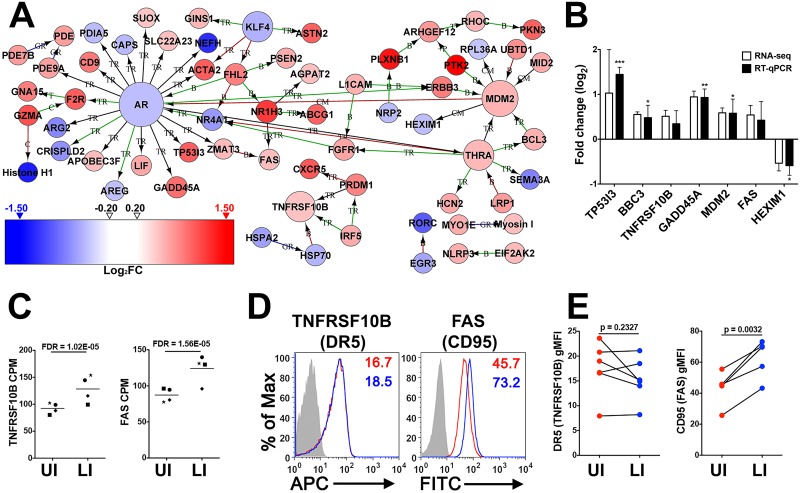
Functional analysis of genes modulated in HIV-1 latency.(A) Protein interaction network (PIN) generated using differentially expressed genes (N = 826) after a log2FC > 0.5 filter was applied (N = 64). Any single nodes not attached to a main hub were removed for clarity. Abbreviations for the type of interaction are as follows: B–Binding, C–Cleavage, CM–Covalent Modification, GR–Group Relation, +P–Phosphorylation, TR–Transcription Regulation, T–Transformation. Edge coloring of Green indicates activation, Red indicates inhibition, Black indicates unspecified, while Blue is utilized for a group relation. Arrows indicate the direction of interactions. The color gradient of log2FC for (A) is included with red indicating upregulation and blue indicating downregulation. (B) RT-qPCR validation of a panel of p53 related genes modulated in HIV-1 latency. Fold change is plotted on the log2 scale with error bars representing standard deviation. Significance for RT-qPCR results was determined with a paired t-test (*p<0.05, **p<0.01, ***p<0.001) and all RNA-Seq results were significant (EdgeR’s FDR corrected p-value < 0.05). (C) Dot plots of gene expression data (i.e., counts per million) from RNA-Seq results for TNFRSF10B (DR5) and FAS (CD95). Abbreviations: UI, uninfected; LI, latently infected. (D) Histograms of DR5 (TNFRSF10B) and CD95 (FAS) protein surface expression from a representative donor. Red line indicates UI and blue line indicates LI. Geometric mean fluorescence intensity (gMFI) is indicated at the right top corner of the histogram and the grey histogram represents unstained control. (E) Surface expression was measured by FACS for DR5 (6 donors) or CD95 (5 donors). Significance was determined with a paired t-test (p-values provided).